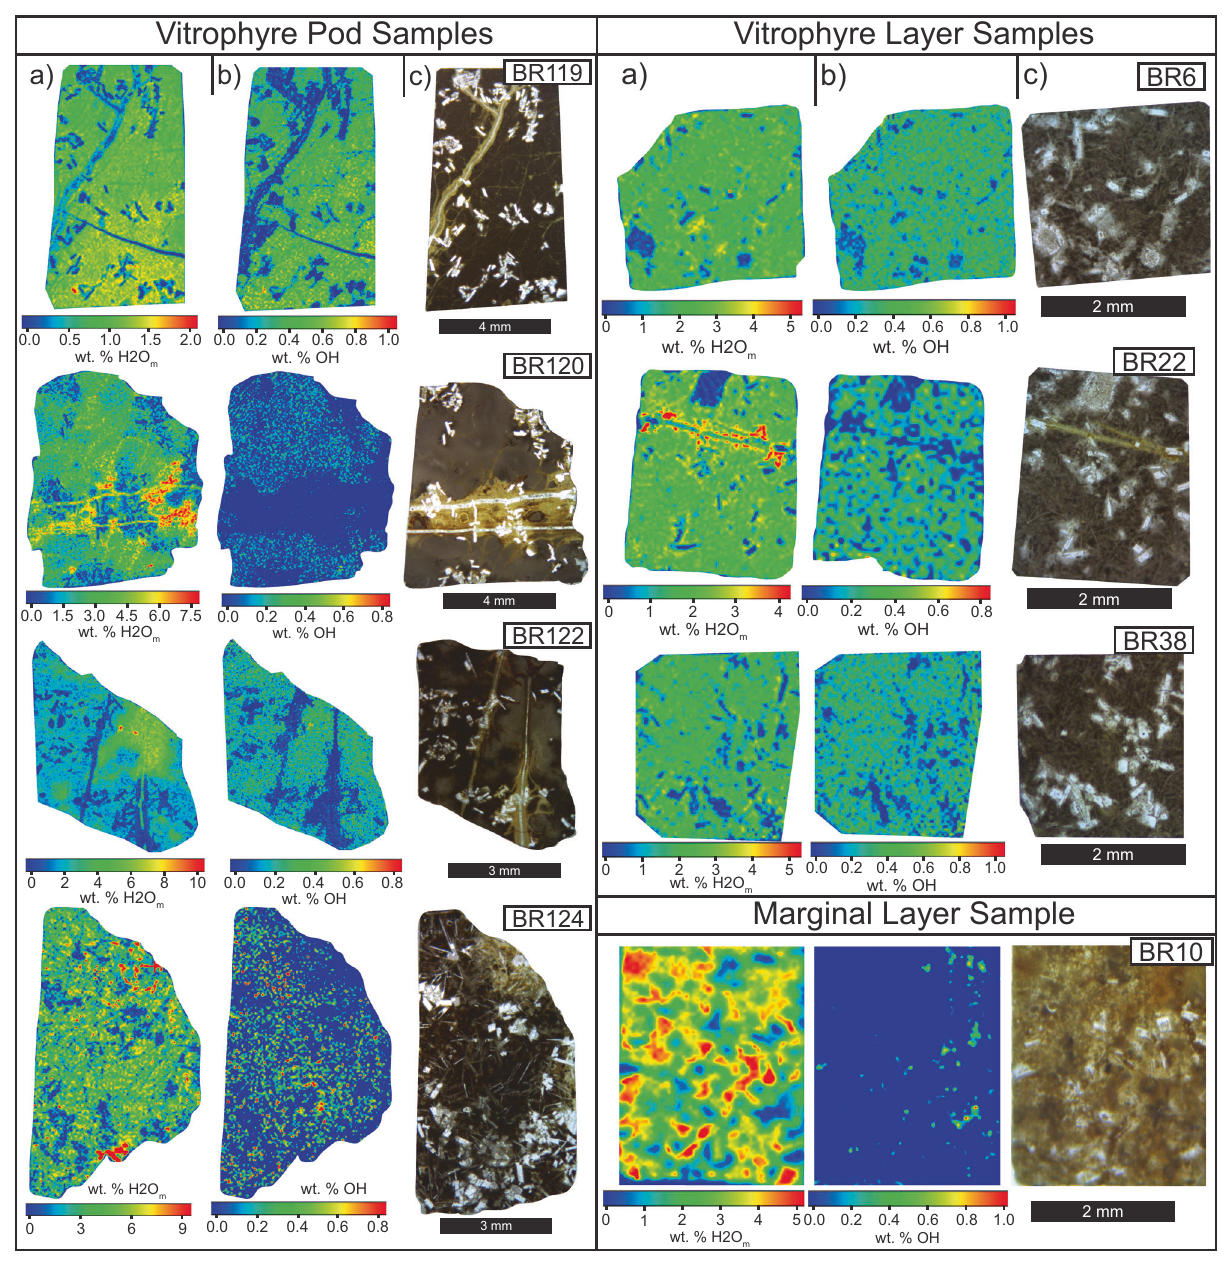
Fig. 3 | Fourier transform infrared spectroscopic data for Butcher Ridge Igneous Complex rocks. Fourier Transform Infrared Spectroscopy (FTIR) water speciation map data for vitrophyre pod, vitrophyre layer, and marginal layer